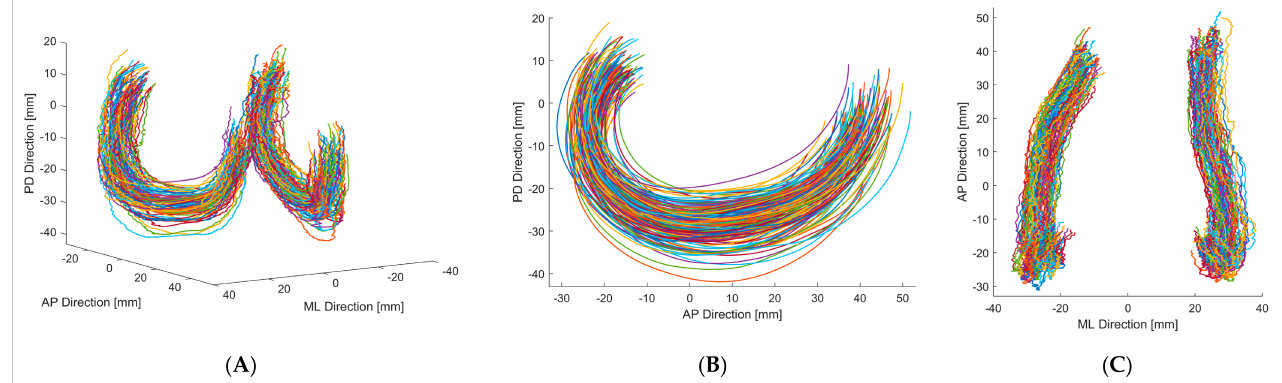
Figure 4. 3D J-Curve contours of both genders. ( A ) Anterior/lateral-posterior/medial view. ( B ) Lateral-medial view. ( C ) Superior-inferior